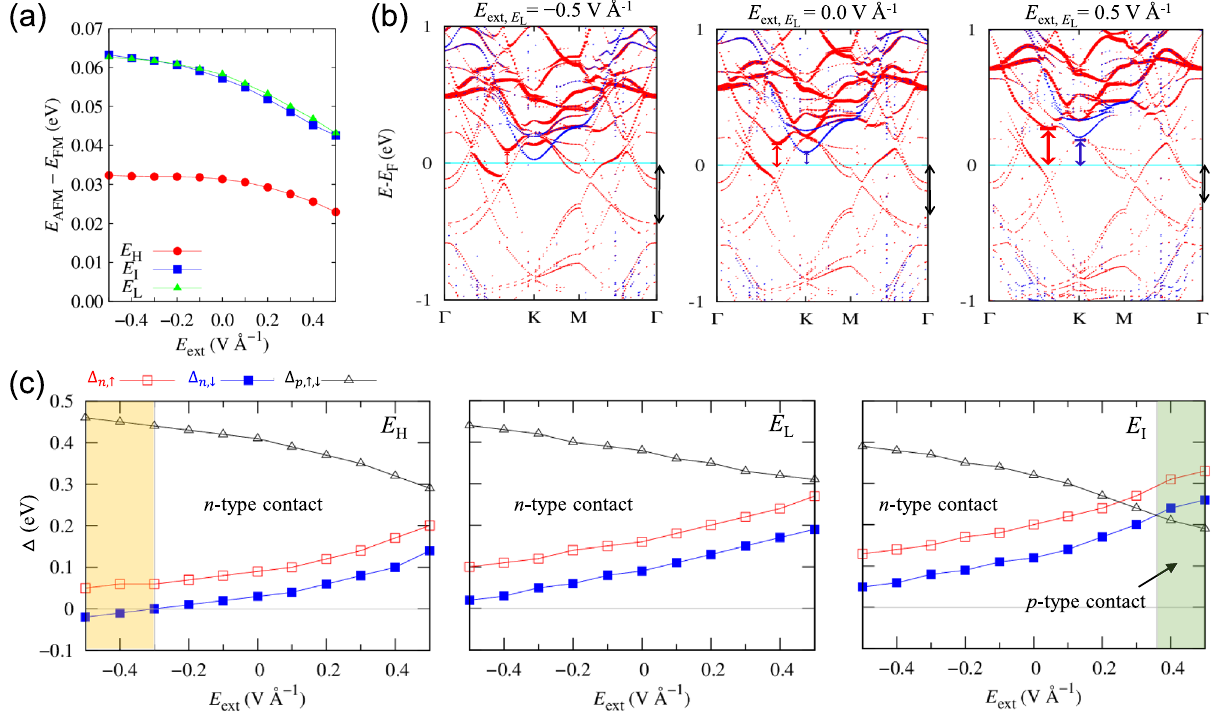
Figure 7. ( a ) Total energy difference between FM and AFM spin alignments between the FGT and CGT layers of E H , E I , and E L heterobilayers with respect to the external electric field. ( b ) Band structures under the external electric field of − 0.5 V Å −1 (left), 0 V Å −1 (middle), and 0.5 V Å −1 (right) for E L structure. The spin-up (red) and spin-down (blue) bands are projected onto a Cr atom; the color intensity corresponds to the projection magnitude. The band-edge magnitudes relative to the Fermi level are indicated by colored arrows. ( c ) Spin- dependent n -type ( (cid:31) n ) and p -type ( (cid:31) p ) band-edge changes as a function of external electric field for E H ↑↓ ↑↓ (left panel), E L (middle panel), and E I (right panel)